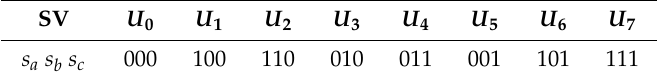
Table 1. Space vectors (SVs) of the MPCC.